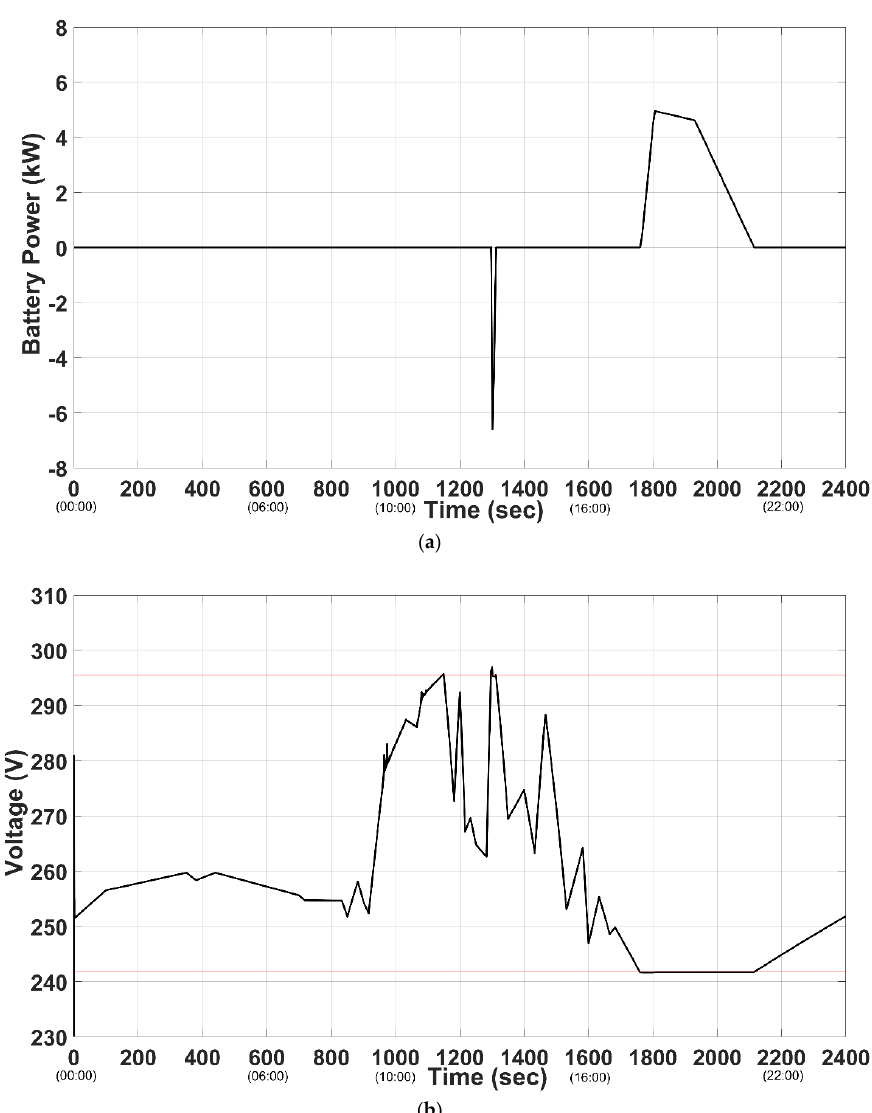
Figure 15. Bus 7: ( a ) the active power exchanged with the power grid and ( b ) the voltage profile when voltage regulation is activated.